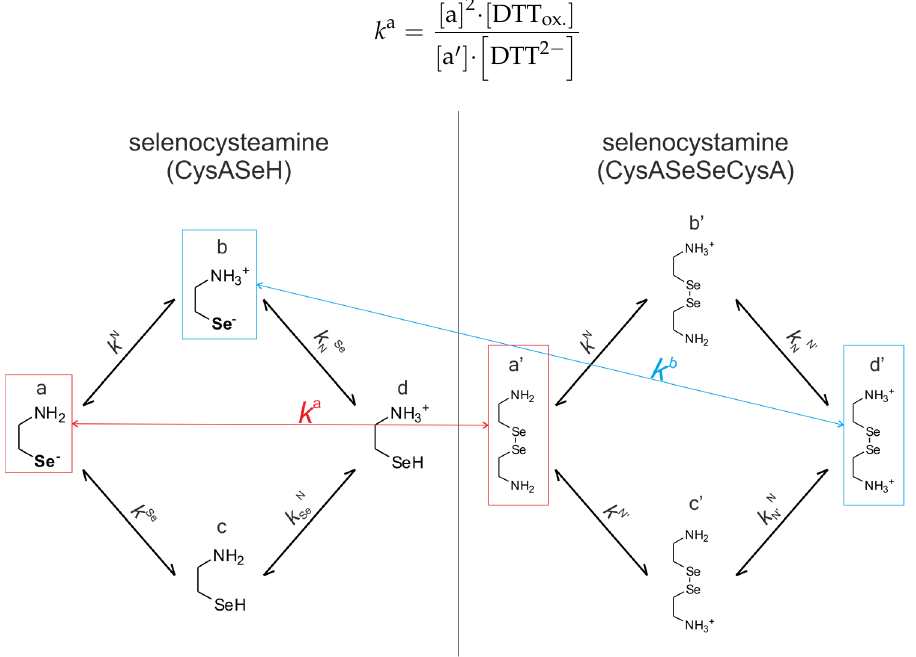
Figure 6. The coexisting protonation and redox microequilibria of selenocysteamine and seleno- cystamine; N, and Se labels denote the amino, and selenolate groups, respectively. Reproduced from [49].